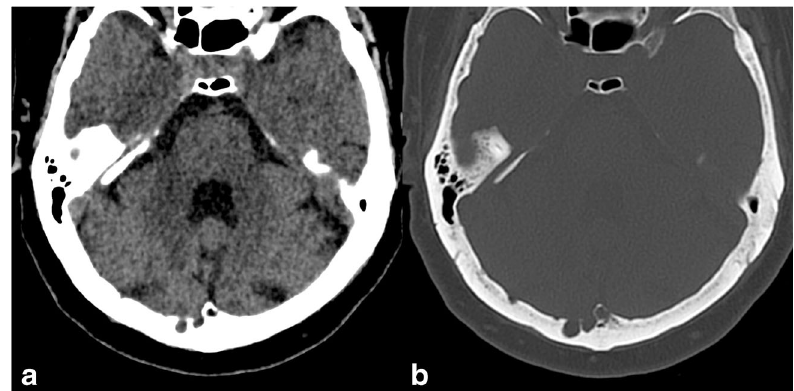
(AGs). Axial computed tomography (CT) images with brain ( a ) and bone ( b ) windows showing two well-defined, round- shaped lesions with cerebrospinal fluid (CSF) density, protruding into the calvarium along the right transverse